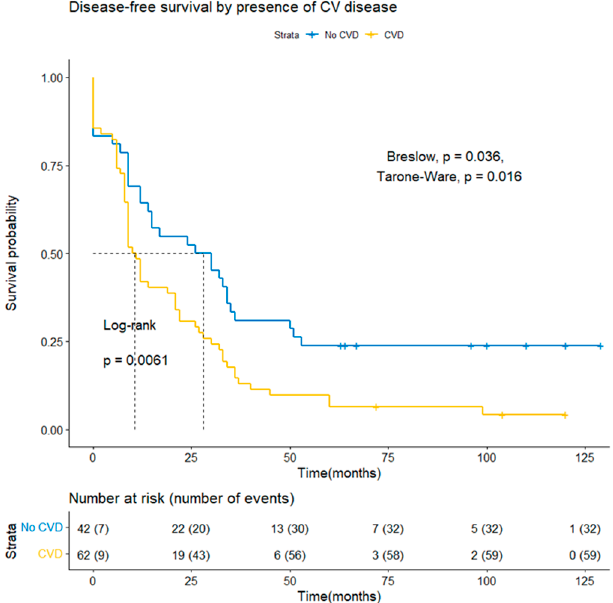
Figure 2. Comparison of CVD and No-CVD groups for disease-free survival by Kaplan–Meier sur- vival analysis.